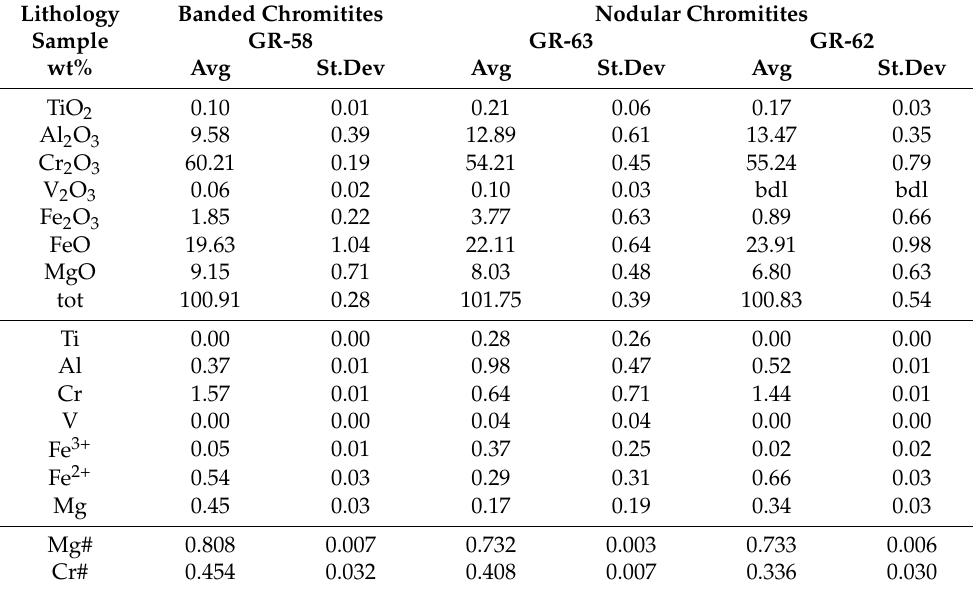
Table 3. Major and minor elements average composition and standard deviation of chromite cores from Nea Roda banded and nodular chromitites; Mg# = [Mg/(Mg + Fe 2+ )]; Cr# = [Cr/(Cr + Al)]. Lithology Banded Chromitites Nodular Chromitites Sample GR-58 GR-63 GR-62